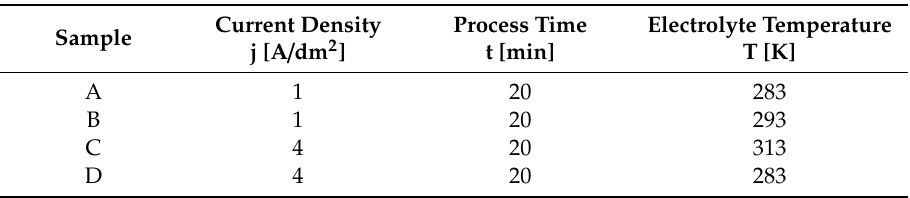
Table 2. Anodizing process conditions.